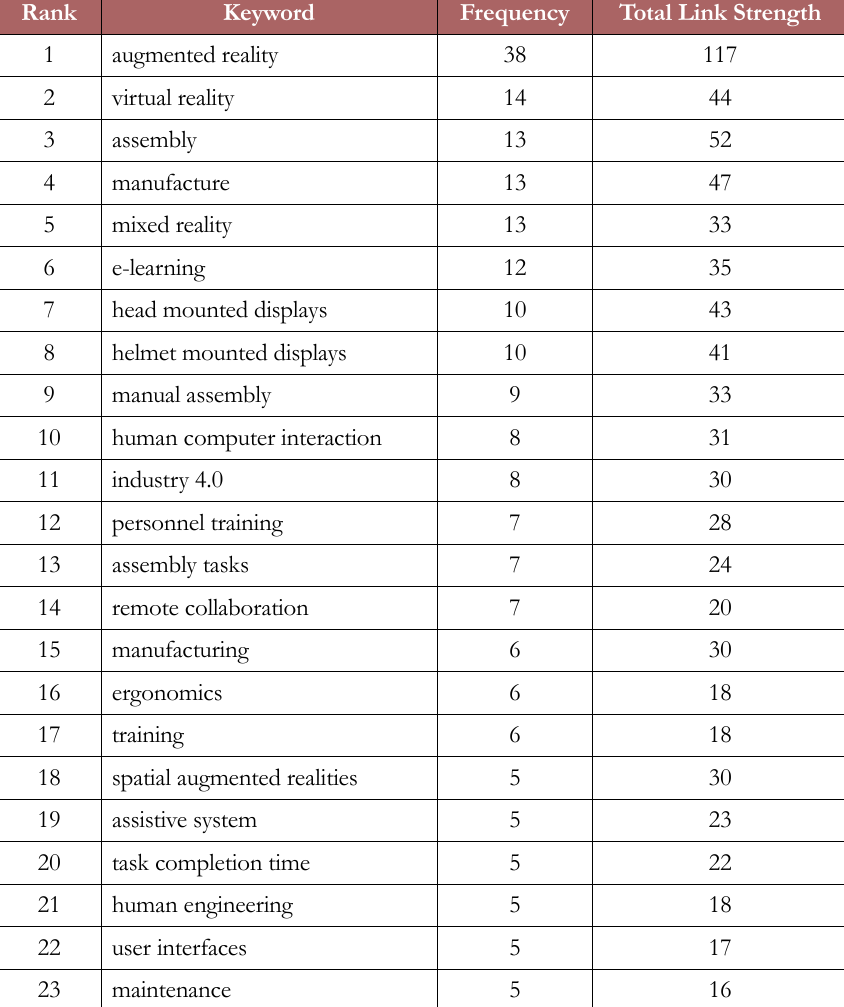
Table 2. Keywords occurrences